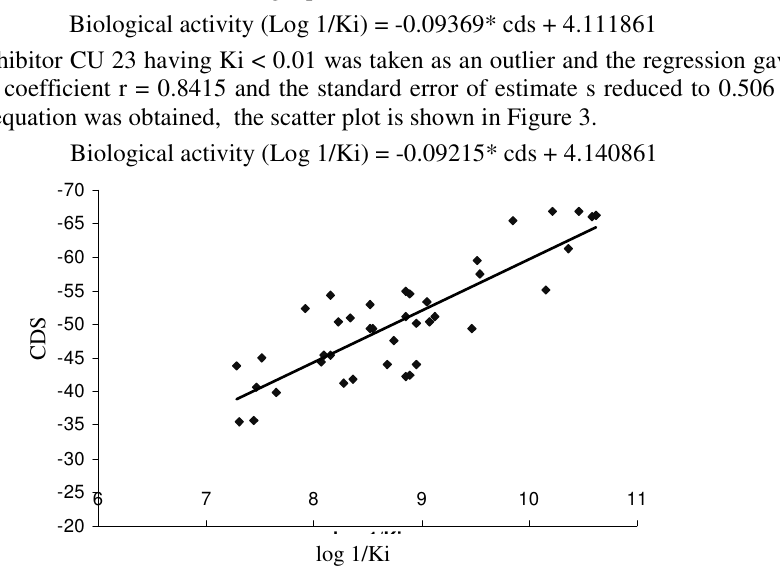
Figure 3. Scatter plot of biological activity in log 1/Ki Vs Combined dock score (CDS)